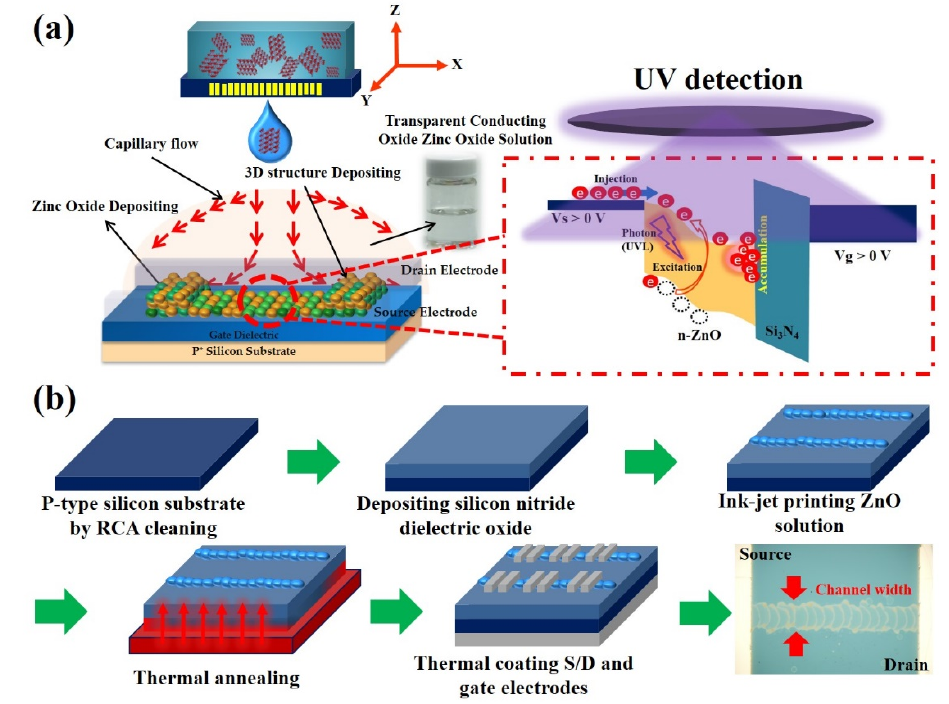
Figure 1. Schematic of ink-jet printing of ZnO thin-film transistors (TFTs) for a ultraviolet (UV) photodetector. ( a ) The ink-jet printing three-dimensional channel structure induced by the co ff ee ring e ff ect and mechanism of the ultraviolet light-induced photocurrent in the photoactive of ZnO film. ( b ) The fabrication procedure of ZnO-based TFTs by ink-jet printing with low-temperature processing.